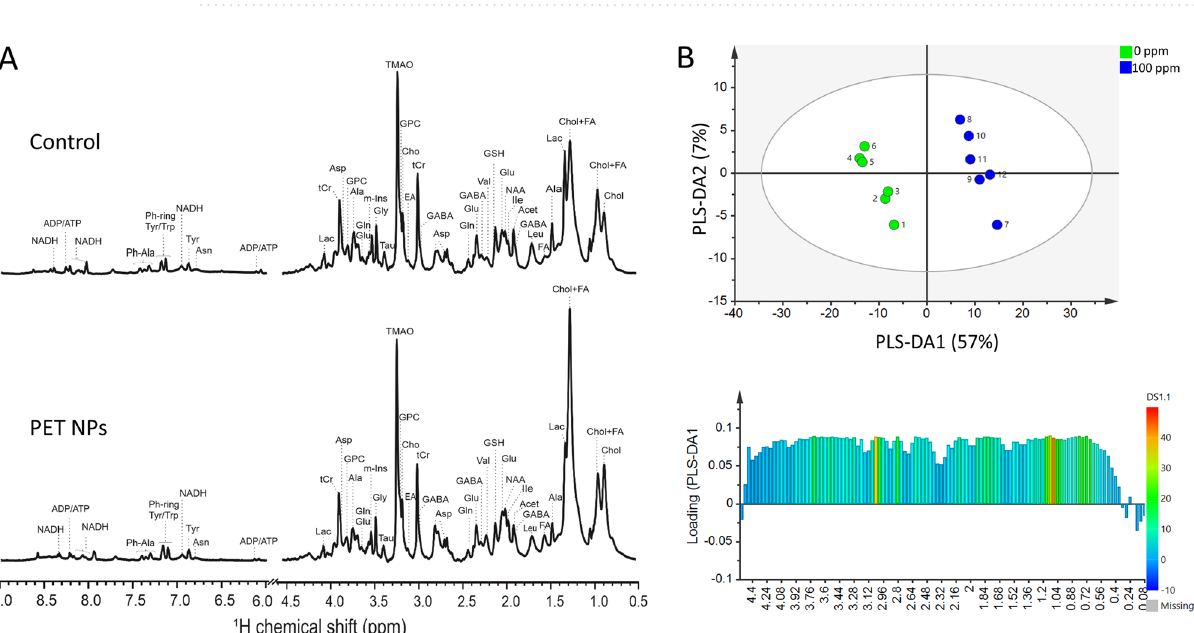
Figure 5. ( A ) Representative high-resolution magic angle spin (HRMAS) NMR spectra of control and PET NPs (100 ppm) exposed zebrafish embryos. 72 hpf zebrafish embryos were treated with PET NPs for 24 h. Red arrows indicate an increase and decrease of metabolites. Abbreviations: Ala = alanine; Asn = aspargine; Asp = Aspartate; ADP = adenosinediphosphate; ATP = adenosinetriphosphate; Cho = choline; Chol = cholesterol; EA = Ethanolamine; FA = fatty acid; GABA = γ-aminobutyric acid; Gln = glutamine; Glu = glutamate; Gly = glycine; GPC = glycerophosphocholine; GSH = glutathione; Lac = lactate; m-Ins = myo- inositol; NAA = N-acetylaspartate; NADH/NAD + = reduced/oxidized nicotinamide adenine dinucleotide; Phe = phenylalanine; Tau = Taurine; tCr = total creatin; Trp = tryptophan; Tyr = tyrosine; TMAO = trimethylamine N-oxide. ( B ) Multivariate analysis of the HRMAS NMR spectra (n = 6 per group) using orthogonal partial least square-discriminant analysis (PLS-DA) modelling (R2 = 0.998, Q2 = 0.962). (upper) Scores plots (PLS-DA1 vs PLS-DA2). The score plot explains 64% of total variance of control clustering in the positive PLS-DA2 scores, and PET in the negative PLS-DA2 scores. (lower) Loading plots of PLS-DA1 for all buckets containing assigned